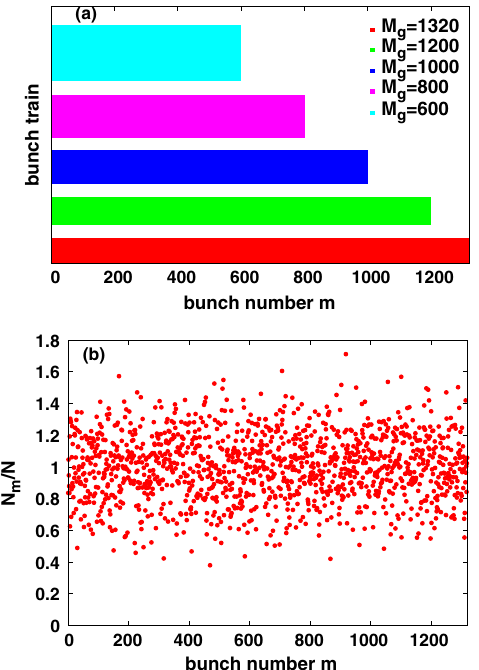
FIG. 5. (a) Bunch trains for different gaps g with number of ¼ M − g , where M ¼ 1320 . The area of the rec- bunches M g tangles equals the total number of particles in the uniform bunch ¼ NM . (b) Single realization of a bunch train with train N T ¼ N ð 1 þ X Þ , where N bunch population N is the bunch m m m population of the uniform bunch train and X is a random m ¼ 0 . 2 , corresponding to variable with zero mean and variance σ X fluctuations in the bunch population of 20%.